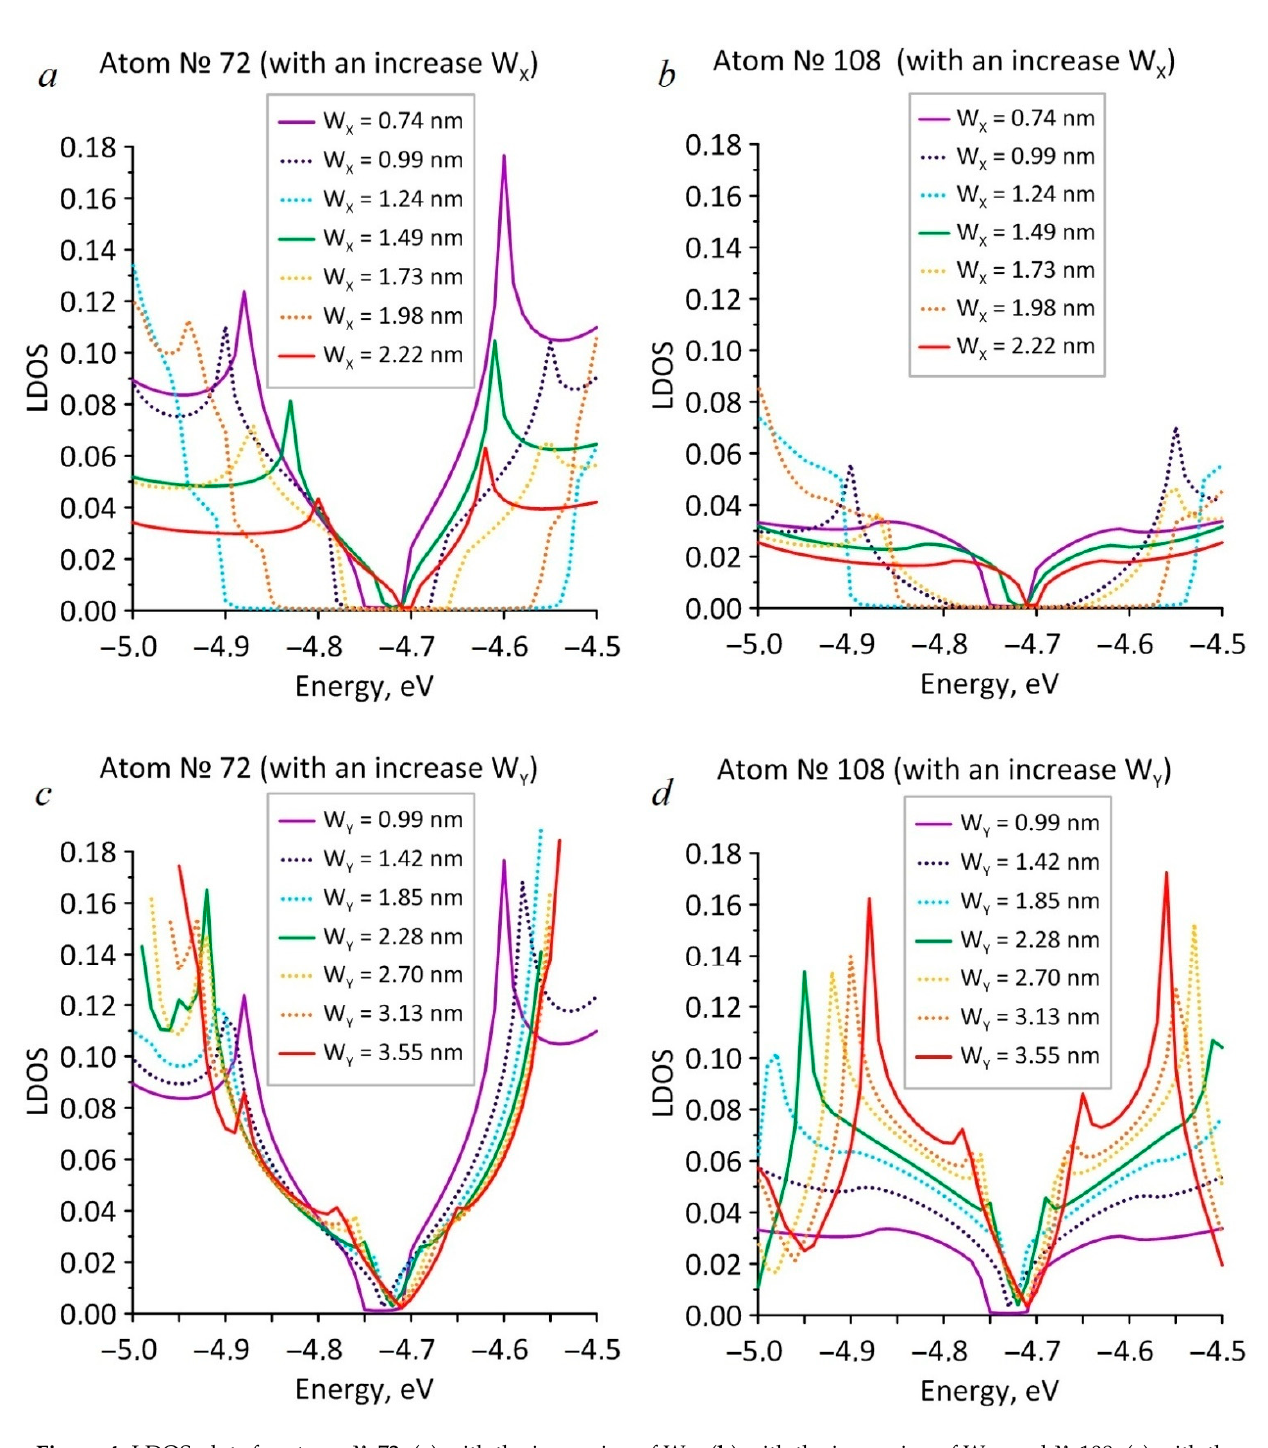
Figure 4. LDOS plots for atoms № 72: ( a ) with the increasing of W X ; ( b ) with the increasing of W Y ; and № 108: ( c ) with the increasing of W X ; ( d ) with the increasing of W Y .